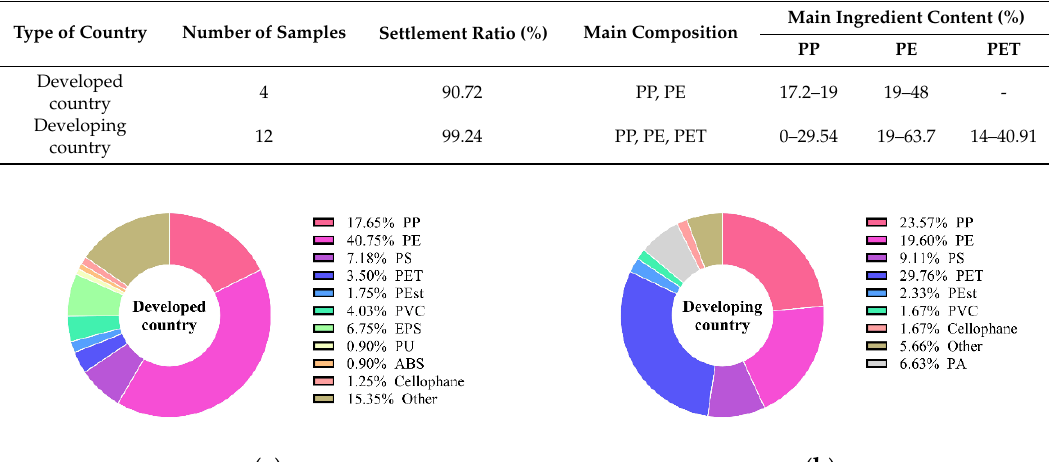
Table 3. A comparison of the main components of microplastics in the waterbodies of developed and developing countries. Polypropylene (PP), polyethylene (PE), and polyethylene terephthalate (PET).